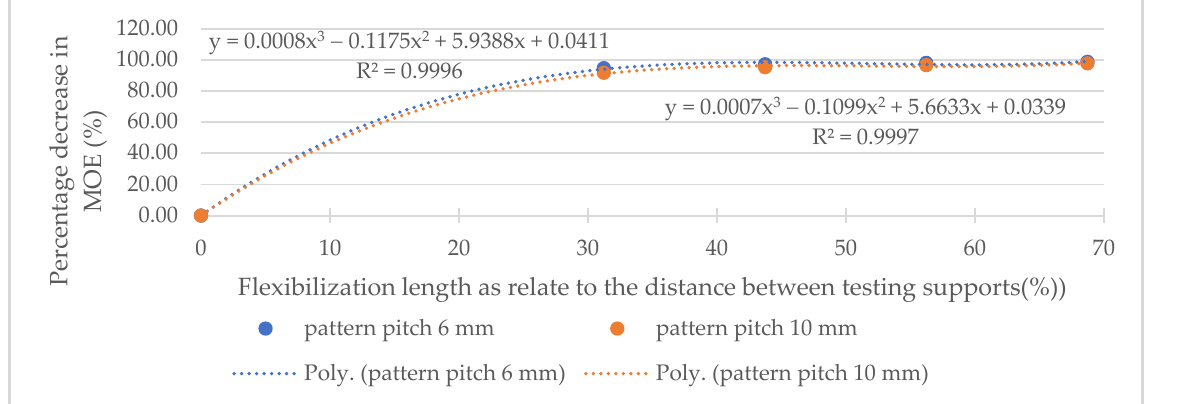
Figure 15. Correlations between percentage change in the MOR with changes in the flexibilization length, for two values of the kerfing pitch.